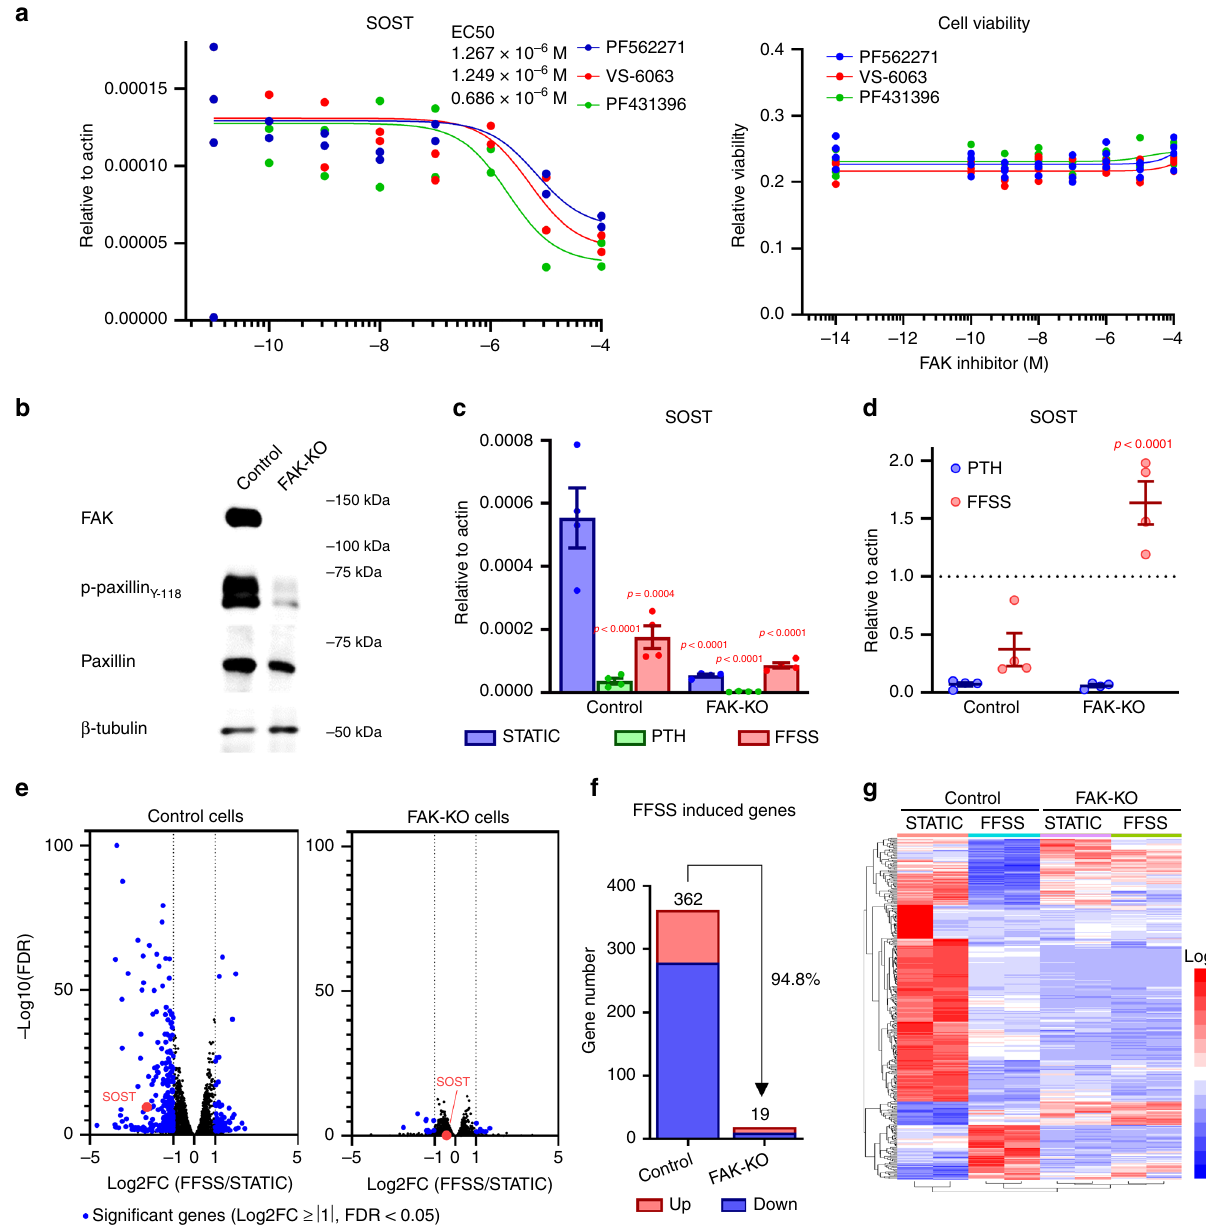
Fig. 3 FAK is required for FFSS-induced gene expression changes in osteocytes. a Left, Sost mRNA expression was assessed after treatment with FAK inhibitors (PF562271, VS-6063, and PF431396) for 4 h ( n = 2 biologic replicates were performed). All FAK inhibitor treatments reduced Sost mRNA expression in Ocy454 cells grown in static conditions. Right, cell viability was measured after 4 h treatment with the indicated FAK inhibitors ( n = 4 biologic cell replicates were performed). Data are shown with each measured value and best fi t curve. b Single-cell FAK-KO cells were generated by CRISPR-Cas9. Protein expression of FAK, p-paxillin (Y118), and paxillin in control and FAK gene deleted (FAK-KO) Ocy454 cells. Phospho-paxillin was signi fi cantly decreased in FAK-KO cells. Each experiment was independently repeated three times. c , d Control and FAK-KO cells were as indicated for 3 h followed by RT-qPCR analysis for Sost . For PTH treatments, cells were treated under static condition at a PTH 1 – 34 concentration of 242 nM. While basal Sost levels are reduced in FAK-KO cells, there is no further decrease in response to FFSS. In contrast, PTH further suppresses SOST in FAK-de fi cient cells. ( n = 4 biologic cell replicates were performed for RNA analysis) P -values adjusted for multiple comparisons are shown versus STATIC condition in control cells. e RNA-seq analyses were performed with control and FAK-KO cells treated for 3 h with/without FFSS. Volcano plots representing the effects of FFSS in each cell type (control and FAK-KO) are shown. Differentially expressed genes (DEGs, log2FC > 1 or < − 1, FDR < 0.05) are shown as blue points.